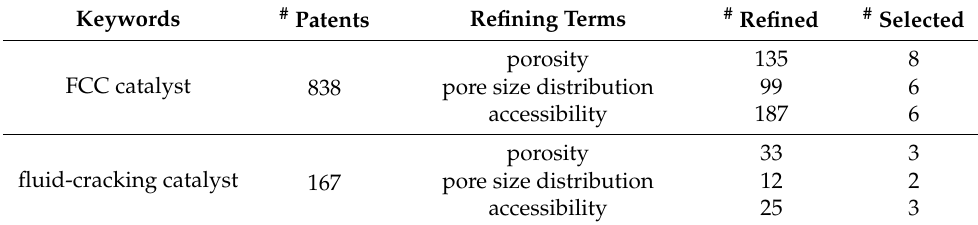
Table 4. Patent search results in the WIPO platform.